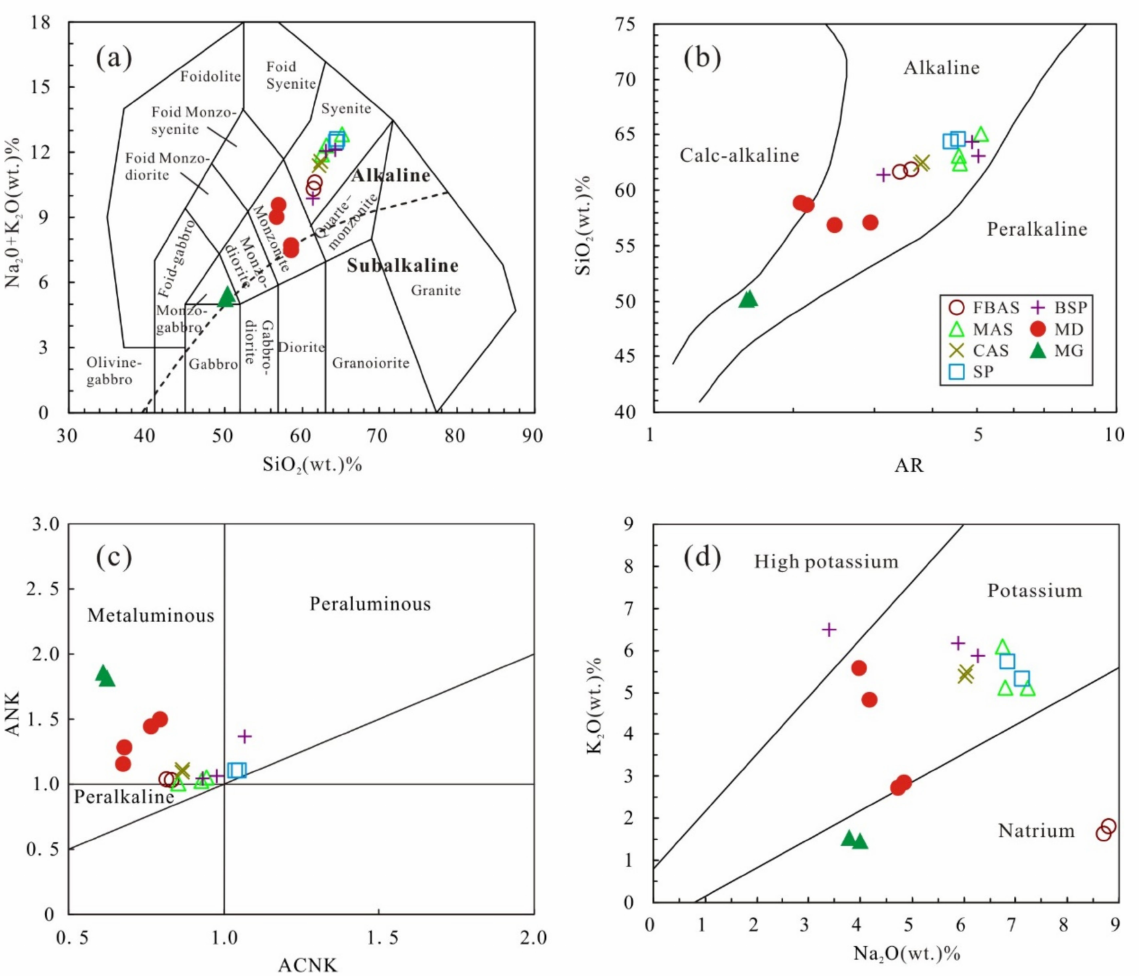
Figure 7. ( a ) TAS diagram for classification [45]; ( b ) SiO 2 versus AR classification diagram [46], AR: [Al 2 O 3 +CaO+(Na 2 O+ K 2 O)]/[Al 2 O 3 +CaO–(Na 2 O+K 2 O)] ( wt% is the percentage calculated after the loss on ignition is removed); ( c ) ANK versus ACNK classification diagram [47], ANK = molar Ai 2 O 3 /(Na 2 O+K 2 O), ACNK = molar Ai 2 O 3 /(Na 2 O+K 2 O+CaO); ( d ) K 2 O versus Na 2 O classification diagram